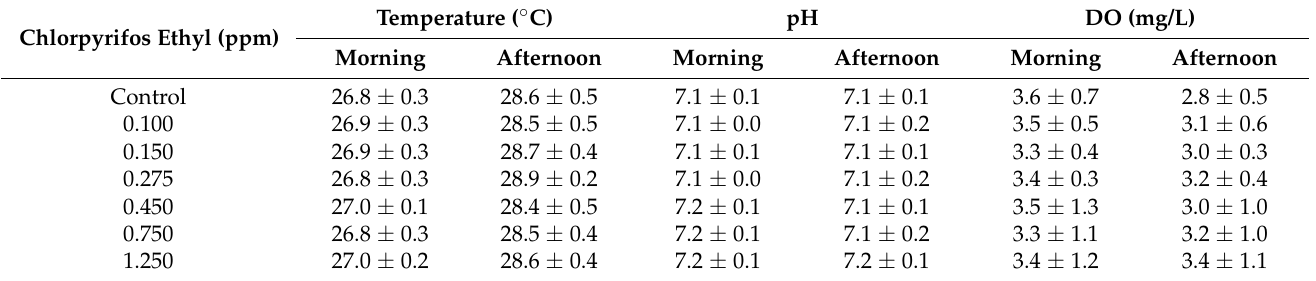
Table 1. Temperature, pH and DO of water in experimental